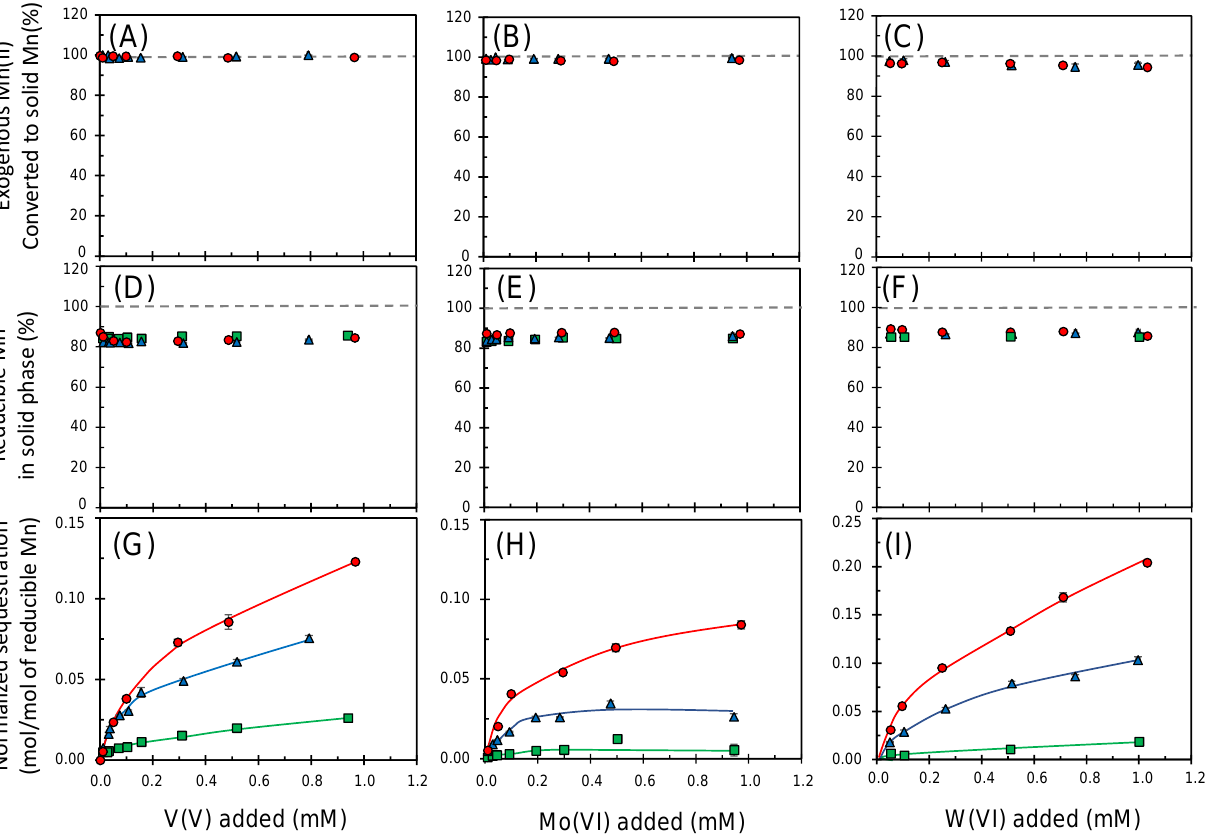
Figure 4. The effects of ( A , D , G ) V(V), ( B , E , H ) Mo(VI), and ( C , F , I ) W(VI) on ( A – C ) the conversion efficiency of exogenous Mn 2+ , ( D – F ) the contents of reducible (oxidized) Mn in the solid phase, measured by the two-step extraction procedure and ( G – I ) sequestration of oxyanions (normalized to reducible Mn). V(V) (0.08 – 0.8 mM) by newly formed primary BMO (~1 mM as Mn) with and without exogenous Mn 2+ at 24 h of the reaction. Green, blue, and red symbols represent data obtained under the experimental conditions of BMO 2.0 /ExMn 0.0 , BMO 1.0 /ExMn 1.0 , and BMO 0.5 /ExMn 1.5 , respectively (See Table 1). The error bars represent the standard deviation (n = 3).